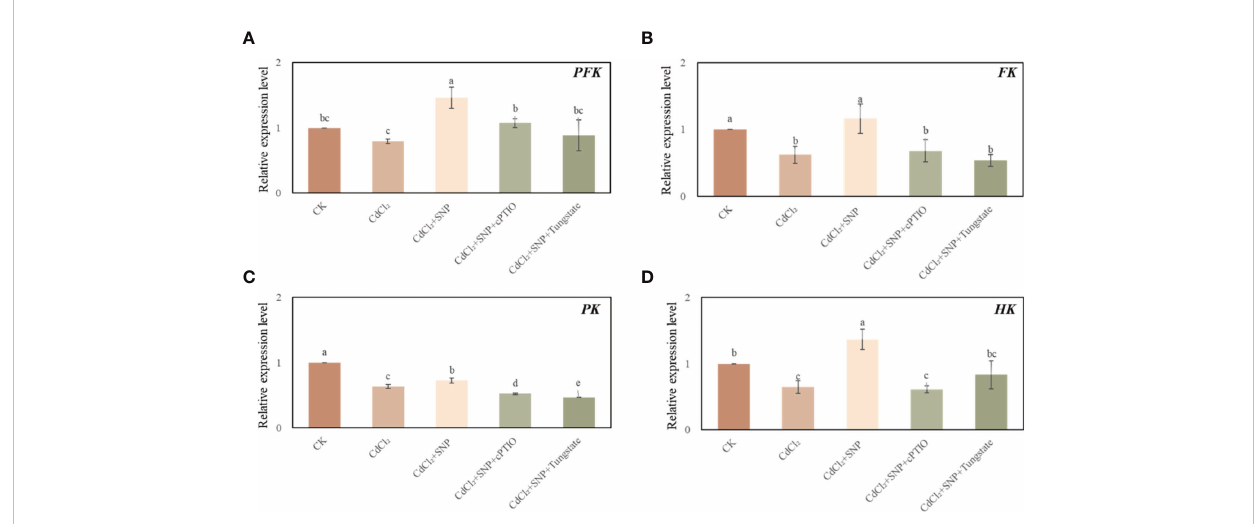
FIGURE 6 Effect of NO on the expression level of PFK ( A ), FK ( B ), PK ( C ) and HK ( D ) in cucumber explants under Cd stress at 48 (h) Explants were incubated for 2 days with distilled water (CK) or 1 m M CdCl 2 , 1 m M CdCl 2 +10 m M SNP, 1 m M CdCl 2 + 10 m M SNP + 200 m M cPTIO, 1 m M CdCl 2 + 10 m M SNP + 200 m M Tungstate. The values (means ± SE) are the average of three independent experiments. Bars with different letters are signi fi cantly different at P < 0.05 according to Duncan ’ s multiple range